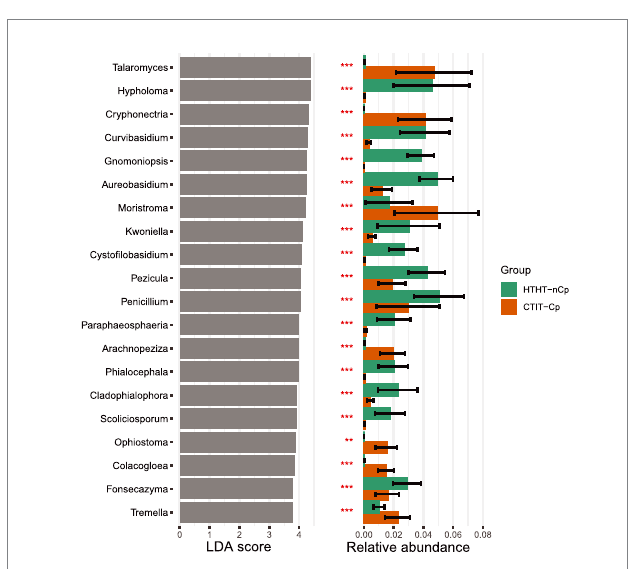
FIGURE 4 Top 20 indicator genera ( p < 0.01) and their relative abundances for fungal communities inhabiting HTHT-nCp and CTIT-Cp samples from bark tissues of European chestnut identified using linear discriminant analysis